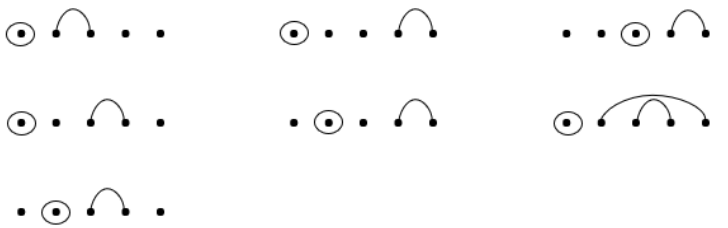
Figure 12. RNA sequences with a length of five and one base-point mutation that contains sequences with wobble base pairs.